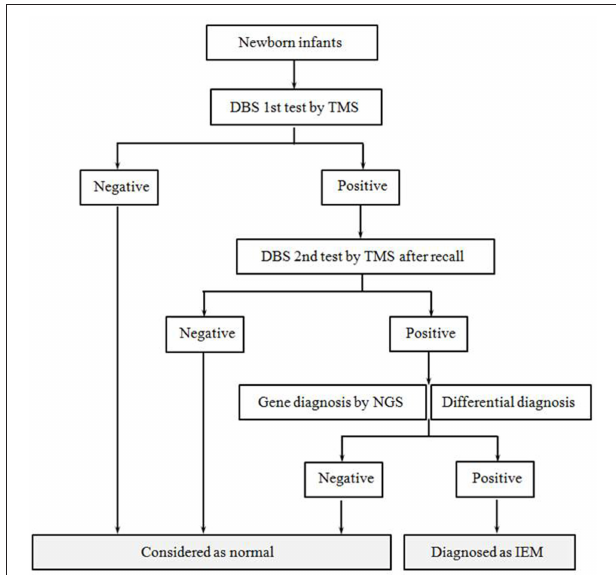
FIGURE 1 | Flow diagram of newborn screening and the diagnostic process. After informed consent, all newborns were accepted screening and diagnosis according to this procedure. The procedure mainly included tandem mass spectrometry screening, positive recall test, differential diagnosis and gene